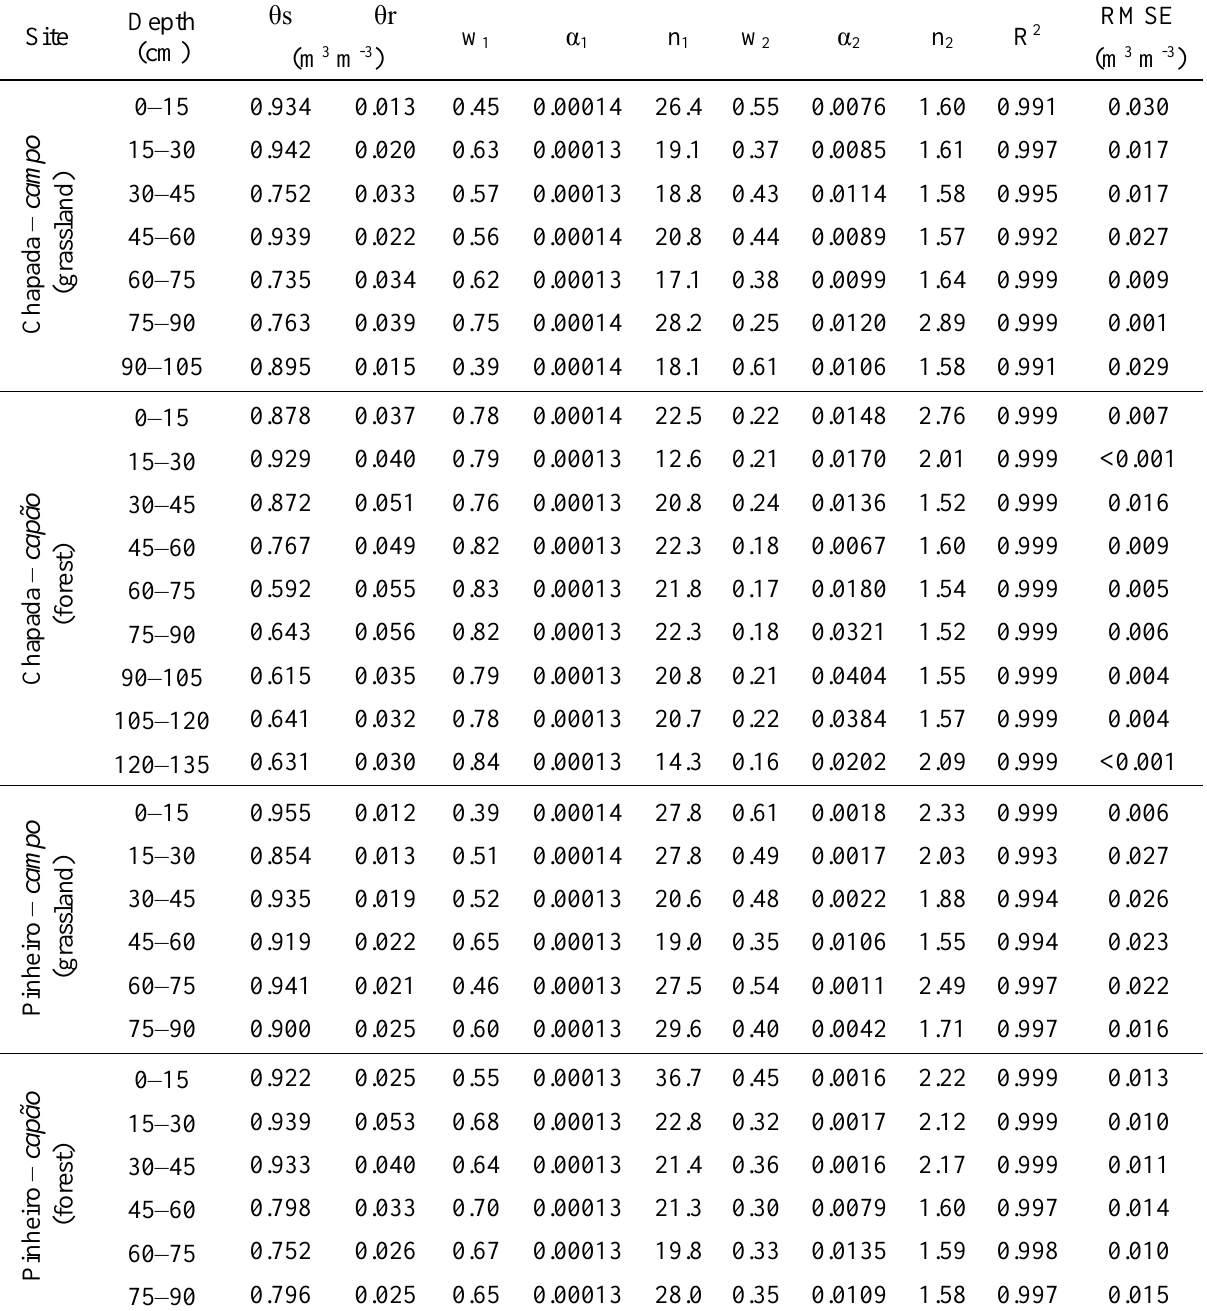
Table 2. Water retention at saturation (θ for the water retention curves, R 2 and RMSE